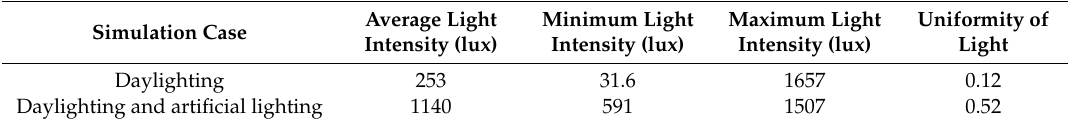
Table 2. Average illuminance (lux) on working plane in case of buildings facing different directions.